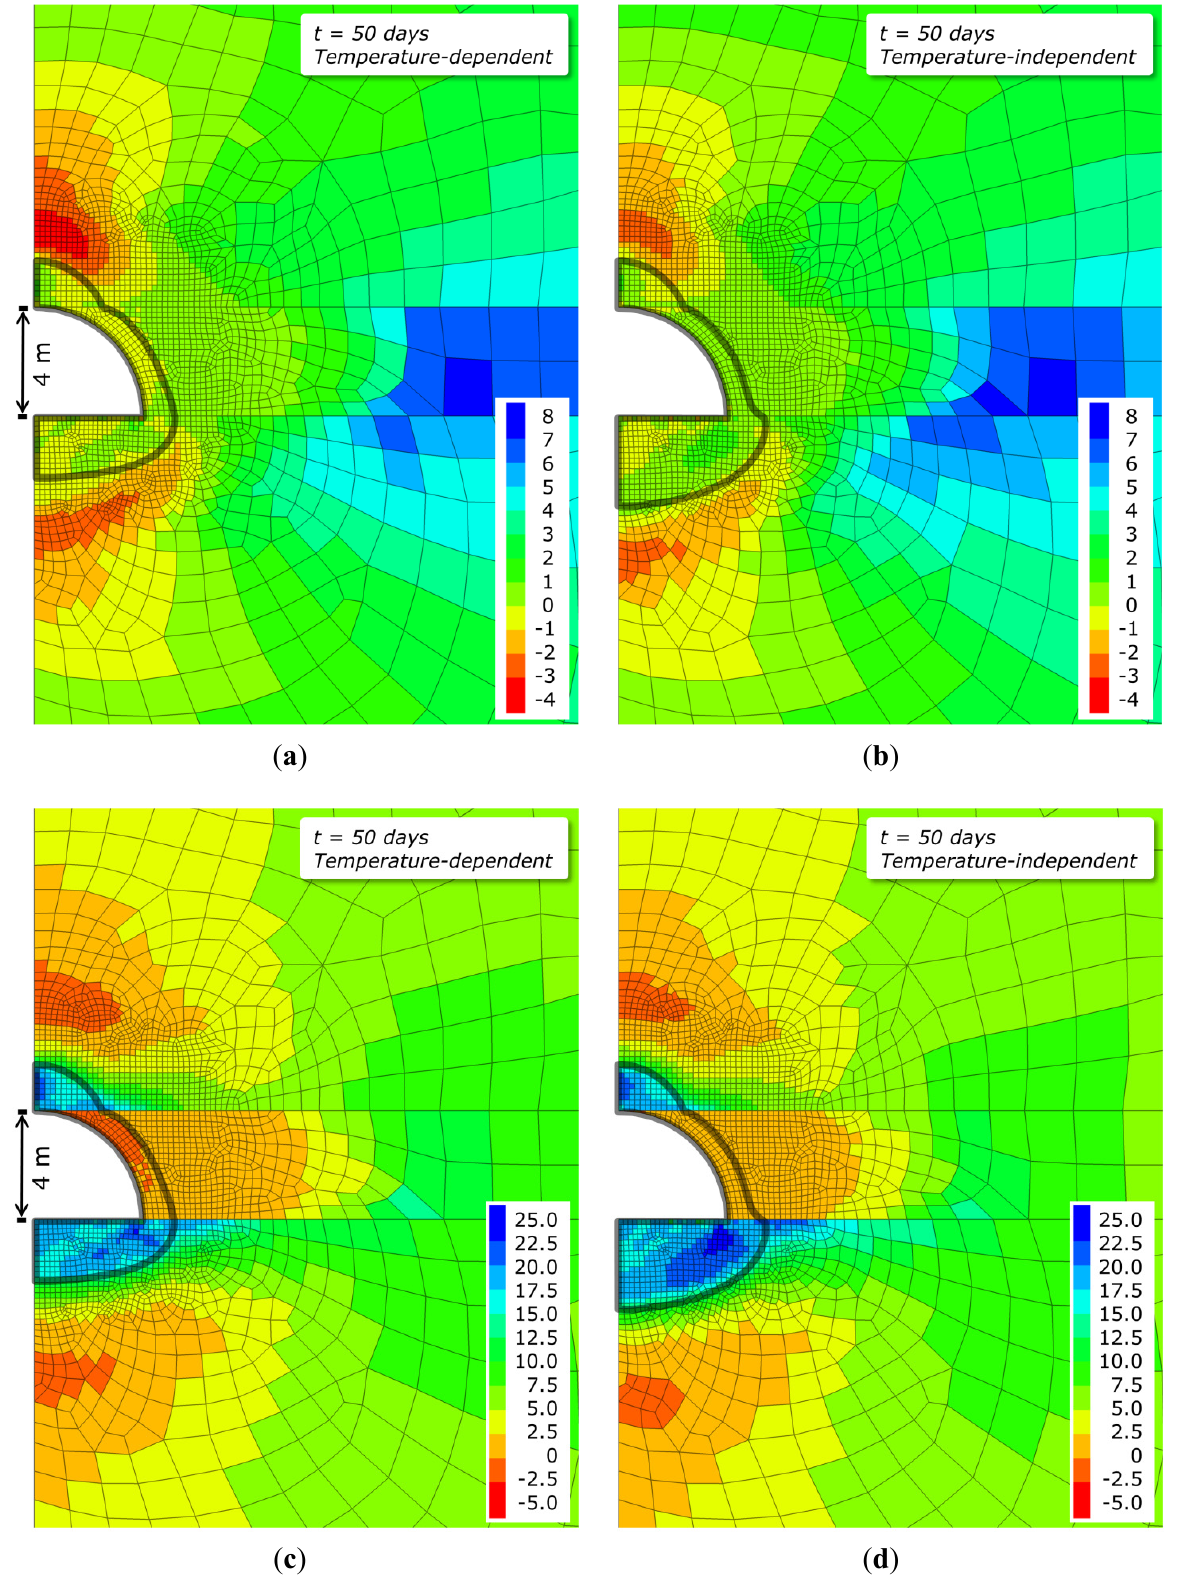
Figure 10. Minimum ( σ 3 = σ H ) principal stress (in MPa) with ( a ) temperature-dependent and ( b ) -independent properties and maximum ( σ 1 = σ V ) principal stress (in MPa) with ( c ) temperature-dependent and ( d ) -independent properties after 50 days of simulation. The grey solid line represents the 200 °C